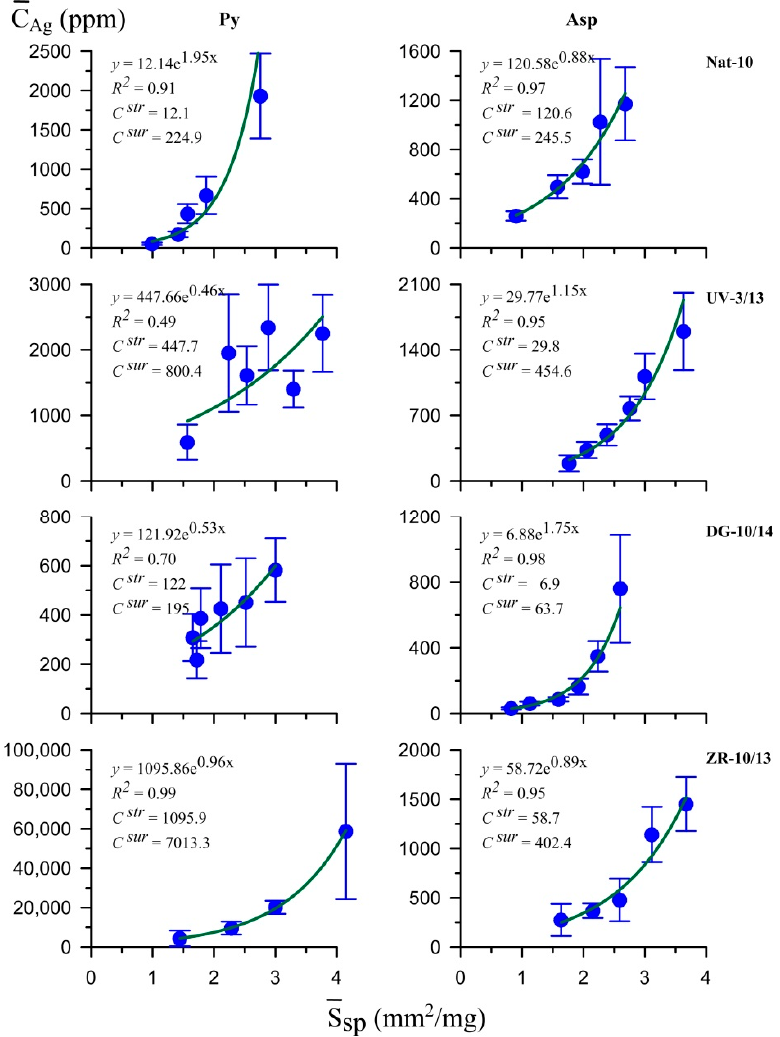
Figure 9. Dependence of the average concentration of evenly distributed Ag in pyrite and arsenopyrite on the specific surface area of an average crystal in size fraction. See Figure 5 for explanations.